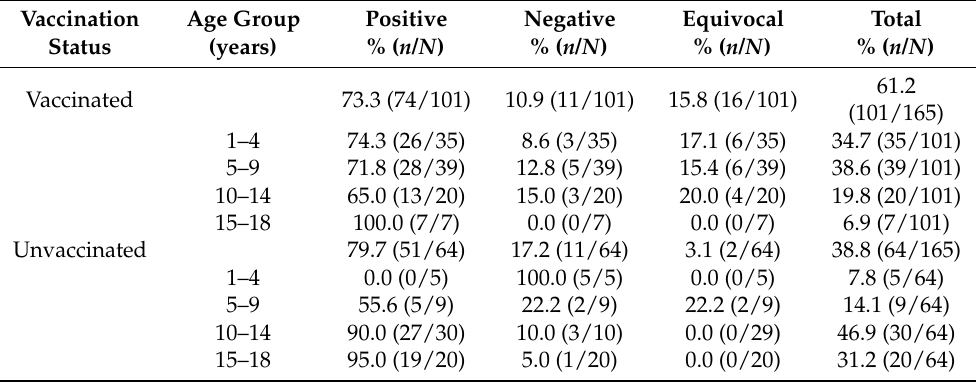
Table 3. Vaccination status of the enrolled subjects related to the serological result (n/N: number of subjects/total).